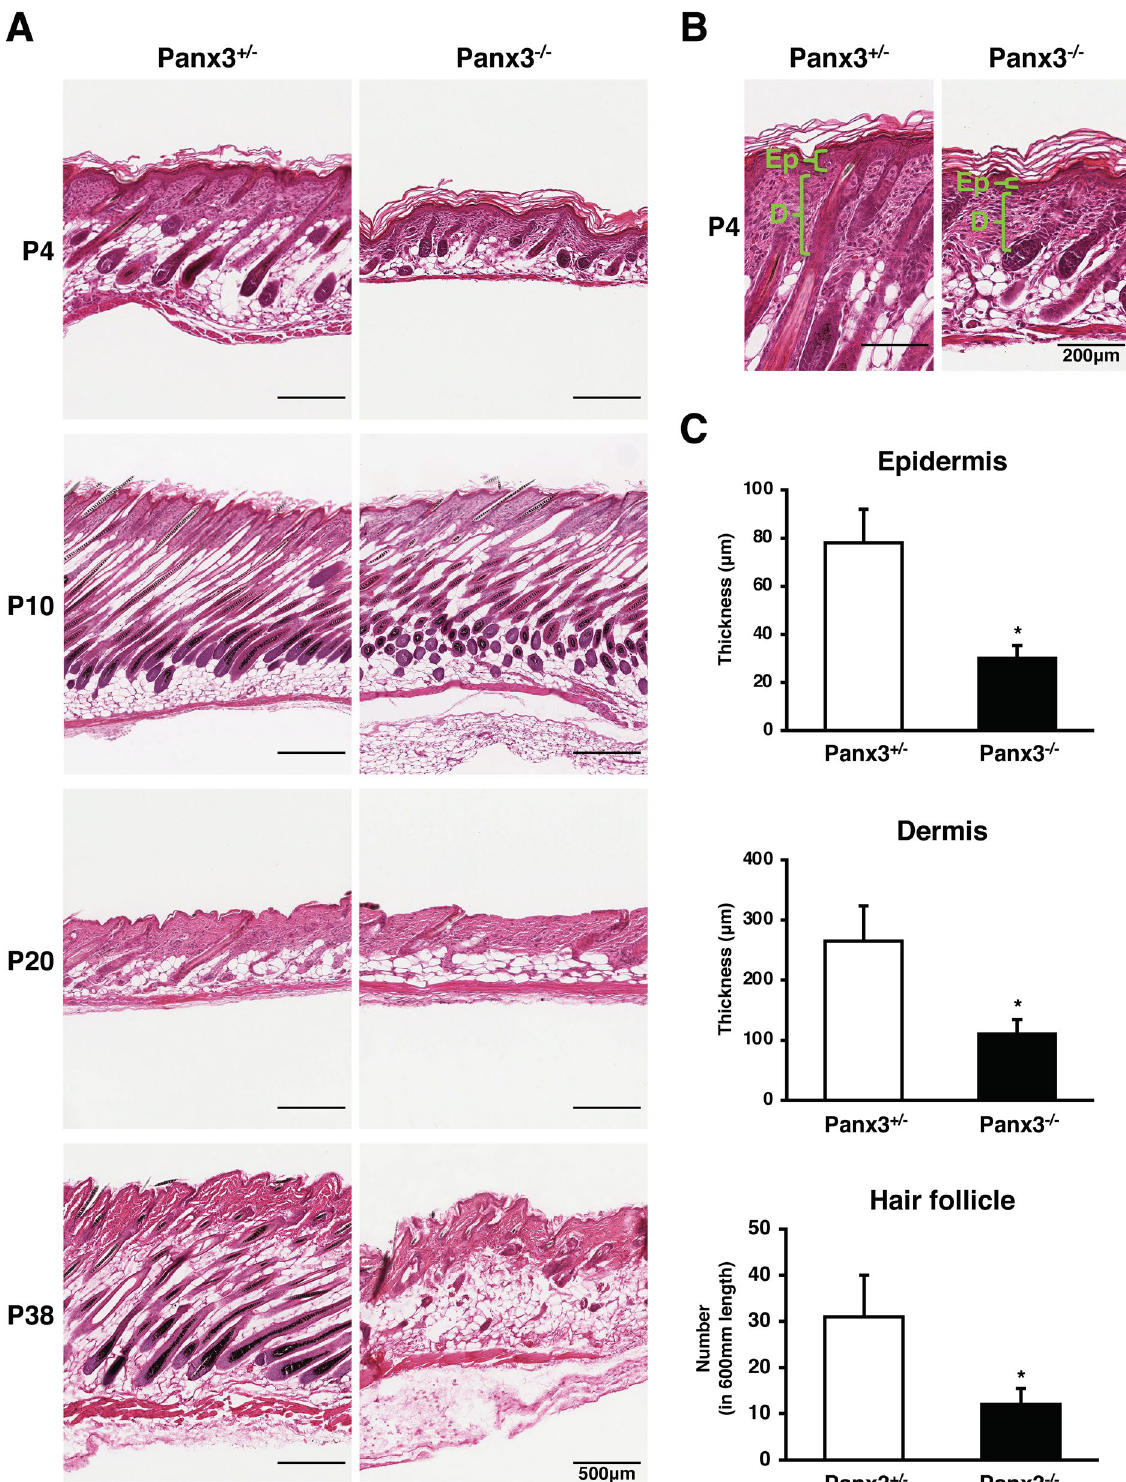
Figure 1. Panx3 regulates skin structure and hair follicle cycle. ( A ) Representative histology images (H&E staining) of Panx3 +/− and Panx3 −/− mice skin on different postnatal days. ( B ) Higher magnification H&E stained images of Panx3 +/− and Panx3 −/− mice skin on P4. Ep: epidermis; D: dermis. ( C ) Measurements of epidermis and dermis thickness and hair follicle numbers in Panx3 +/− and Panx3 −/− mice on P4. * p < 0.01. Error bars represent the mean ± SD; N =